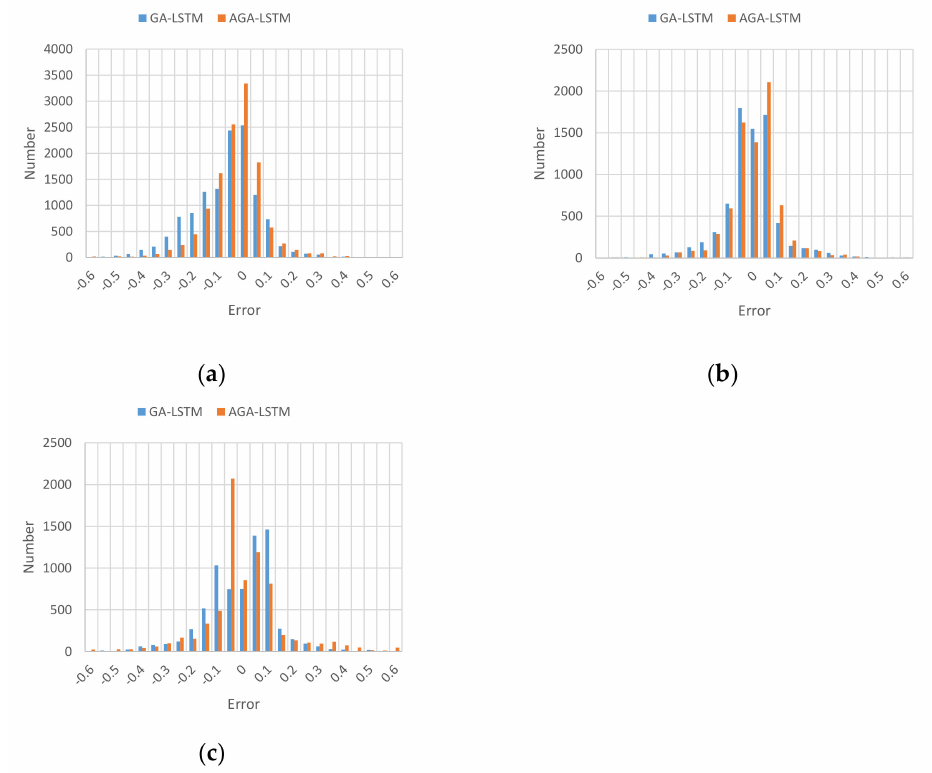
Figure 6. The relative error distributions of DNI; ( a ) error distribution of 5 min prediction model; ( b ) error distribution of 10 min prediction model; ( c ) error distribution of 5 min prediction